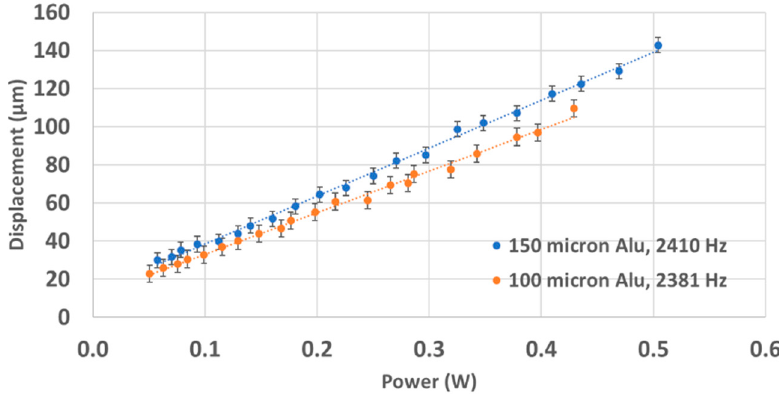
Figure 10. Fiber-tip displacement with response to input power for two aluminum samples with different bridge heights (100 and 150 µm).